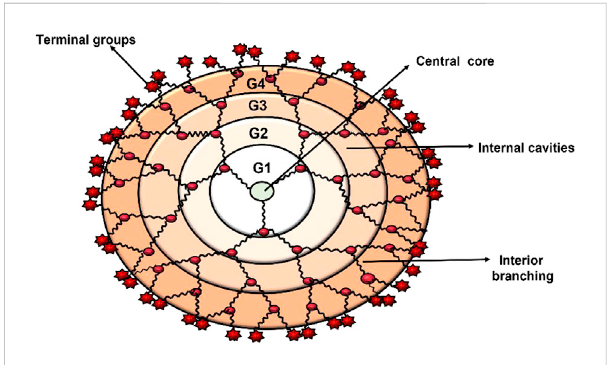
FIGURE 1 Dendrimer architecture at its most fundamental level.